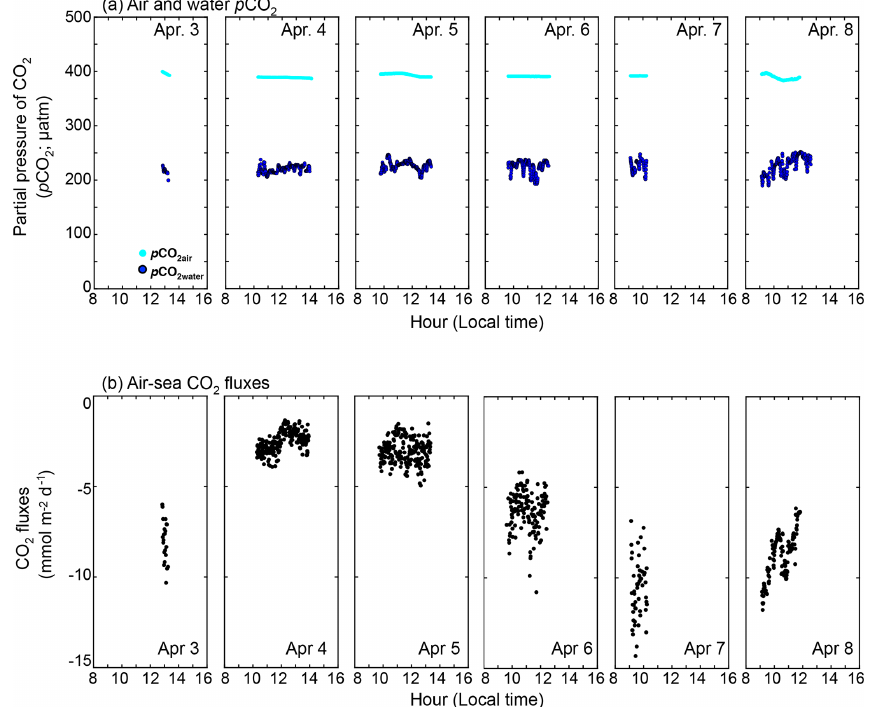
Figure 6. Time series of (a) measured p CO 2water (blue dots) and p CO 2air (cyan dots) (µatm), and (b) calculated CO 2 flux (mmolm − 2 d − 1 ). Negative CO 2 flux indicates that the sea is a sink of CO 2 . The time zone is local